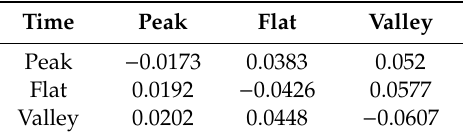
Table A9. Electricity price elasticity coe ffi cient.